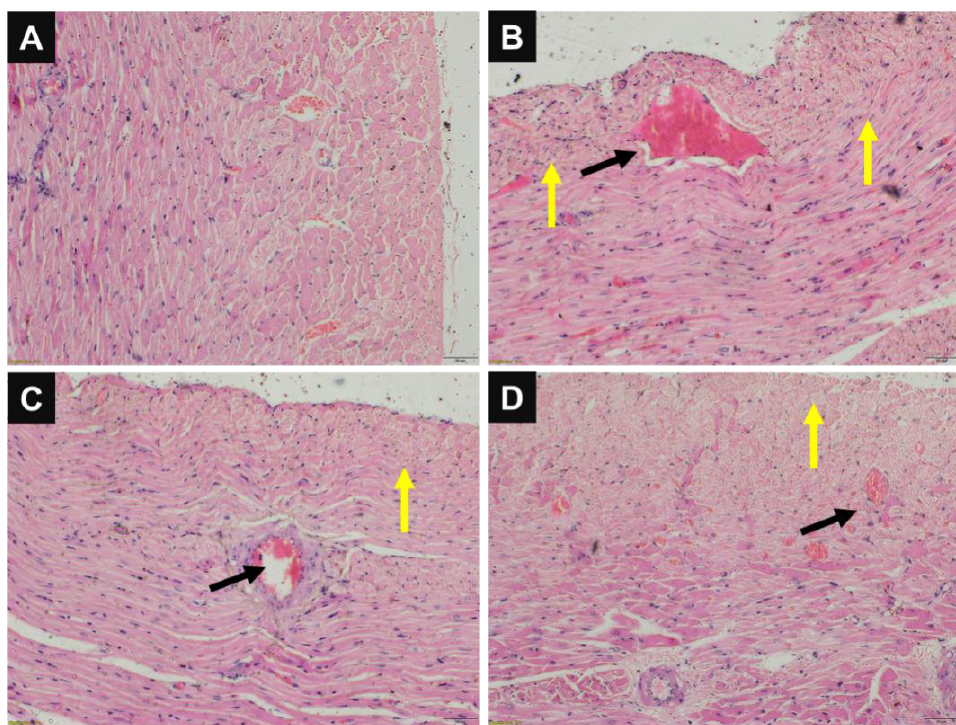
Figure 5. Histopathology studies depicting a ( A ) negative control, ( B ) plain suture, ( C ) plain drug (CPH)-coated suture, and ( D ) CPG-NP-coated suture. The black arrows indicate erythema and the yellow arrows specify the granulation tissue. Note: group I (negative control), group II (plain suture), group III (CPH-coated suture), and group IV (CPG-NP-coated suture); 10× magnification and the scale bar is 50 µm.